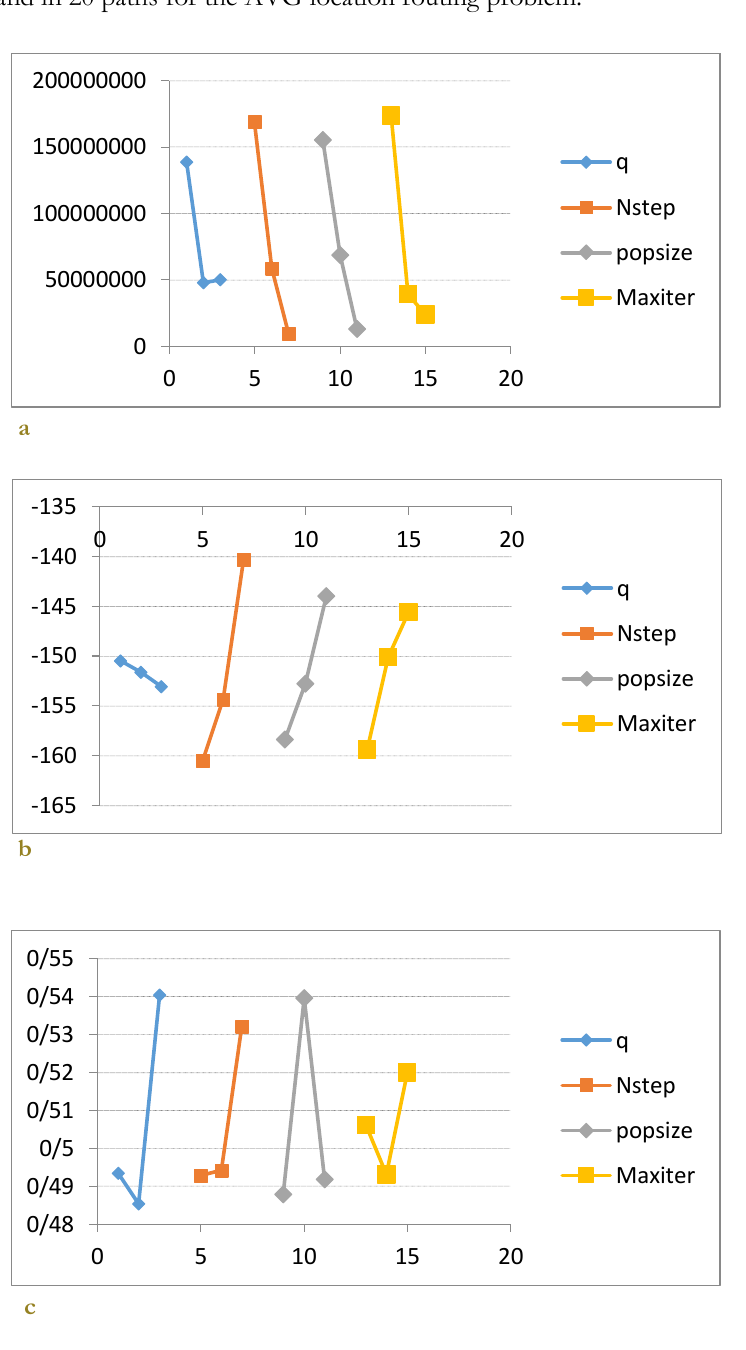
Fig. 8. Taguchi method showing the S/N ratio plot: a. objective; b. seasons period paths and nodes; c. performance